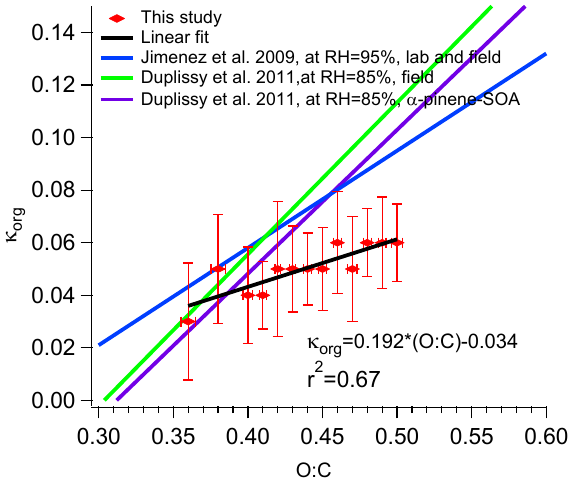
Fig. 8. Correlation between the hygroscopicity parameter κ chem Fig. 8: Correlation between the hygroscopicity parameter  chem vs.  HTDMA , V NH4NO3 <40% and 795  org =0.05. 796 < 40% and κ org = 0 . vs. κ HTDMA , V NH 4 NO 3